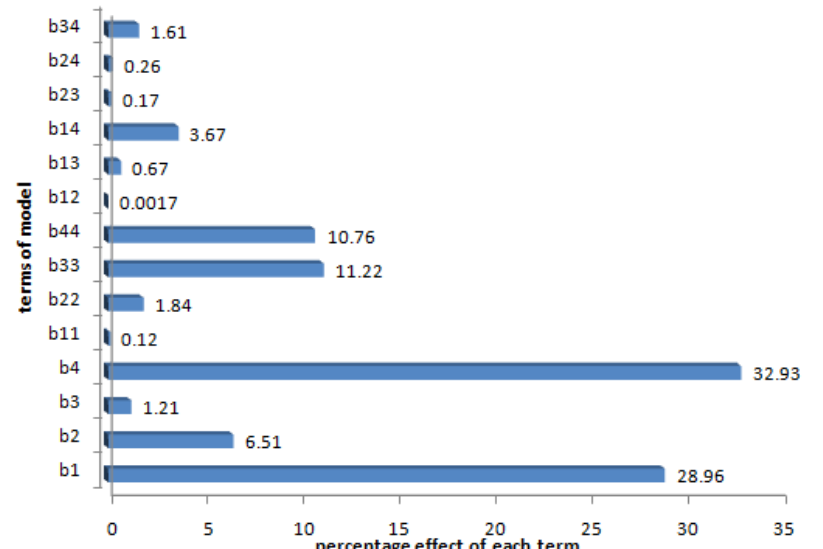
Fig. 6. Percentage effect of each model term obtained using Pareto analysis.